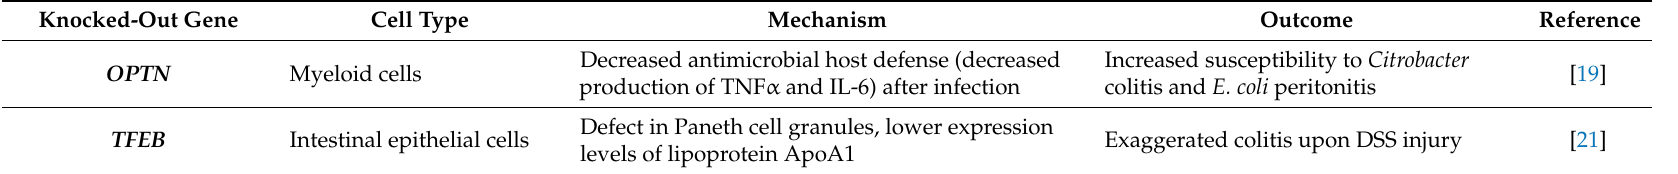
Table 2. Genetic models related to autophagy in intestinal